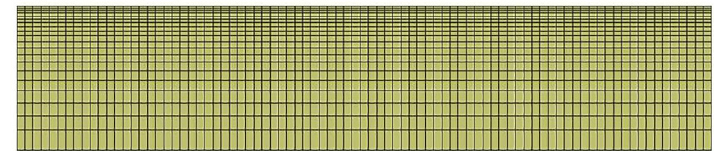
Figure 3. Finite element model of the sample plate.